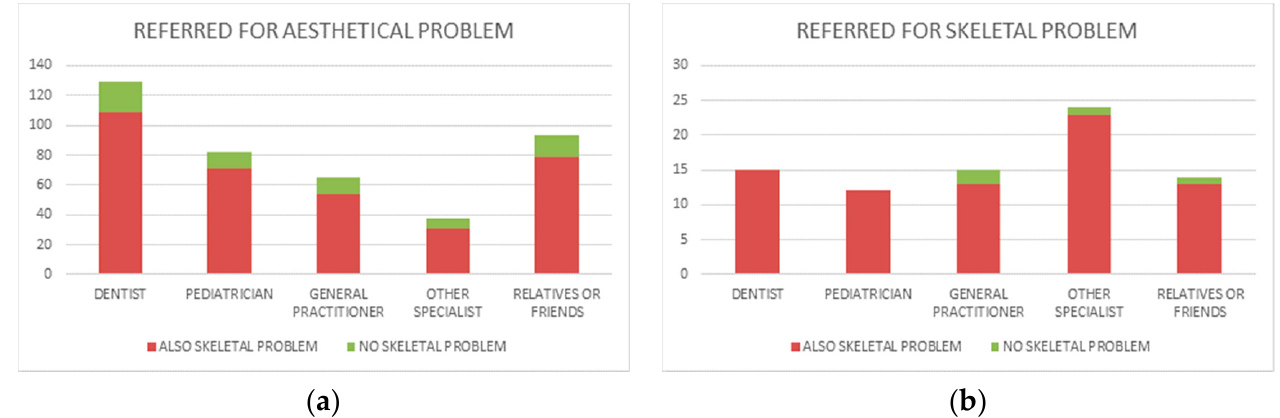
Figure 7. ( a ) In the group referred for aesthetic problems, several patients presented also undiagnosed skeletal disharmonies. ( b ) In the group referred for skeletal problems, almost all the diagnoses were correct.